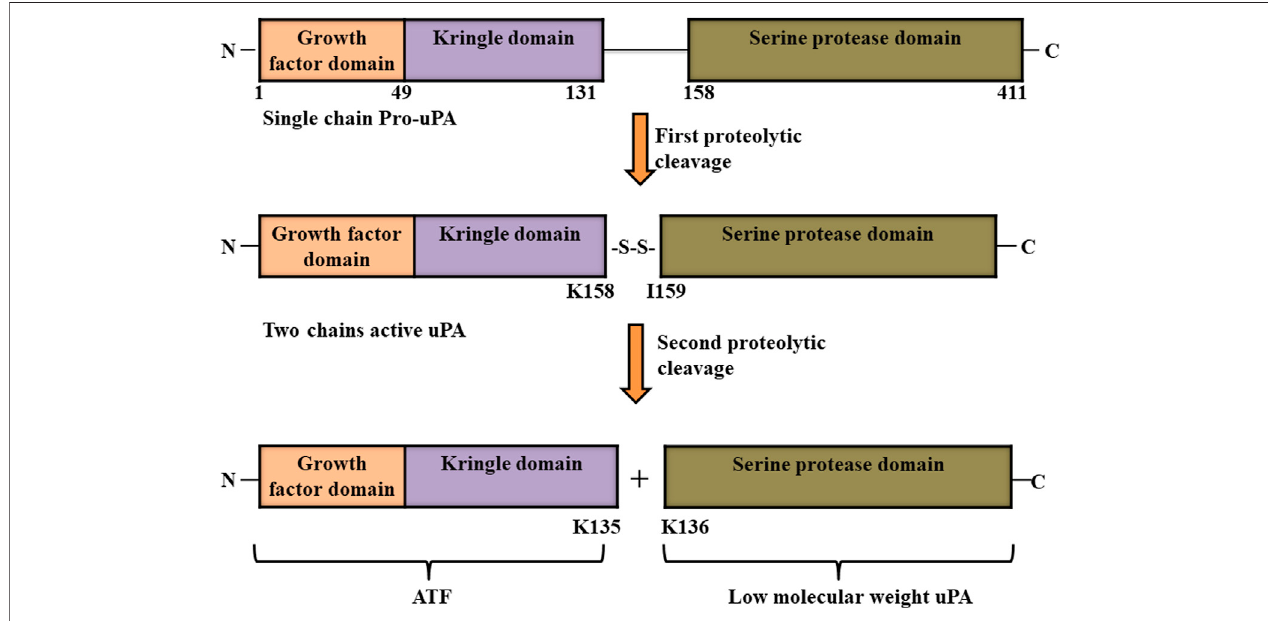
FIGURE 4 | Structure of urokinase-type plasminogen activator (uPA). Pro-uPA is secreted as an inactive single polypeptide chain consisting of a growth factor domain, kringle domain and serine protease domain, and undergoes fi rst proteolytic cleavage between its Lys158 and IIe159. A second-round cleavage at the peptide bond between its Lys135 and Lys 136 totally cleaves the two chains of uPA into two parts: the inactive amino-terminal fragment (ATF) and active low molecular weight form of uPA (Mahmood et al., 2018).